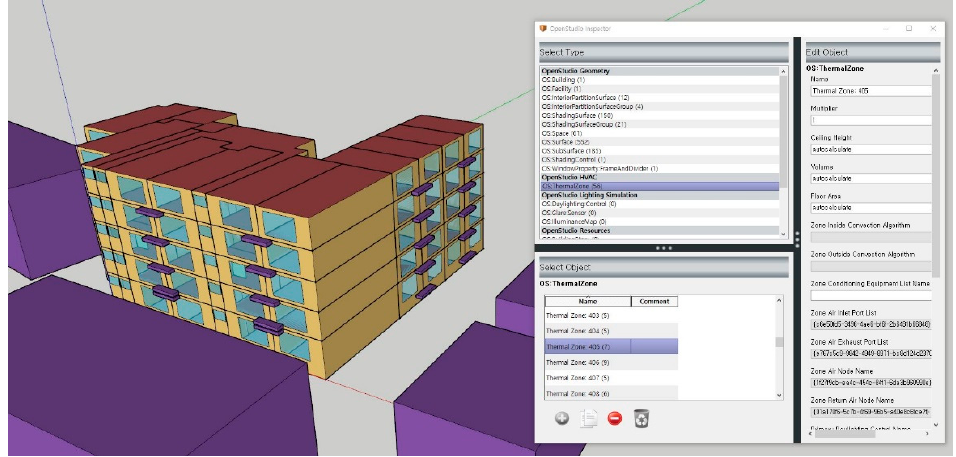
Figure 3. Building modeling for simulation.